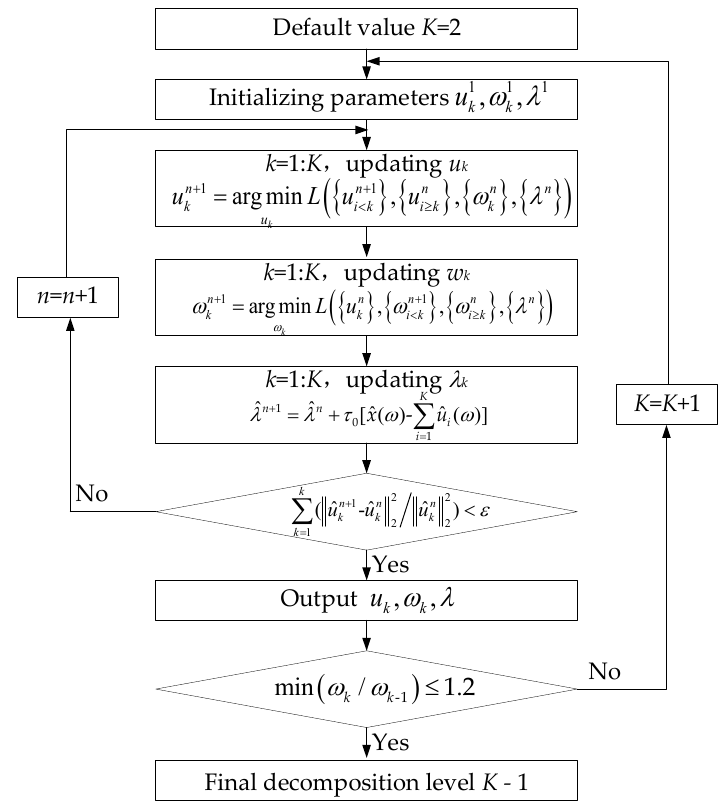
Figure 3. Process of VMD.